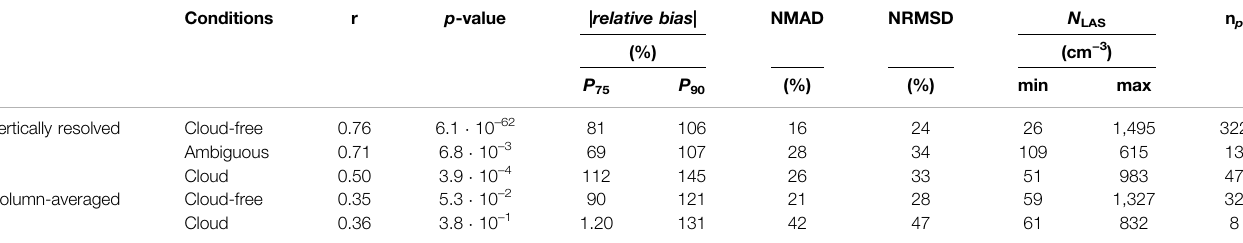
TABLE 3 | Comparison statistics resulting from the comparison ofverticallyresolved N LAS with N HSRL+RSP and resulting from the comparison of column-averaged N LAS with N RSP forthe insitu pro fi lesthatwereclassi fi edascloud-free,ambiguous,andcloud.Thestatisticspresentedforeachcategoryareasfollows(fromlefttoright):r, p -value, P 75 and P 90 of the absolute relative bias (i.e., |relative bias|), NMAD, NRMSD, minimum and maximum N LAS (either vertically resolved or column-averaged), and n p